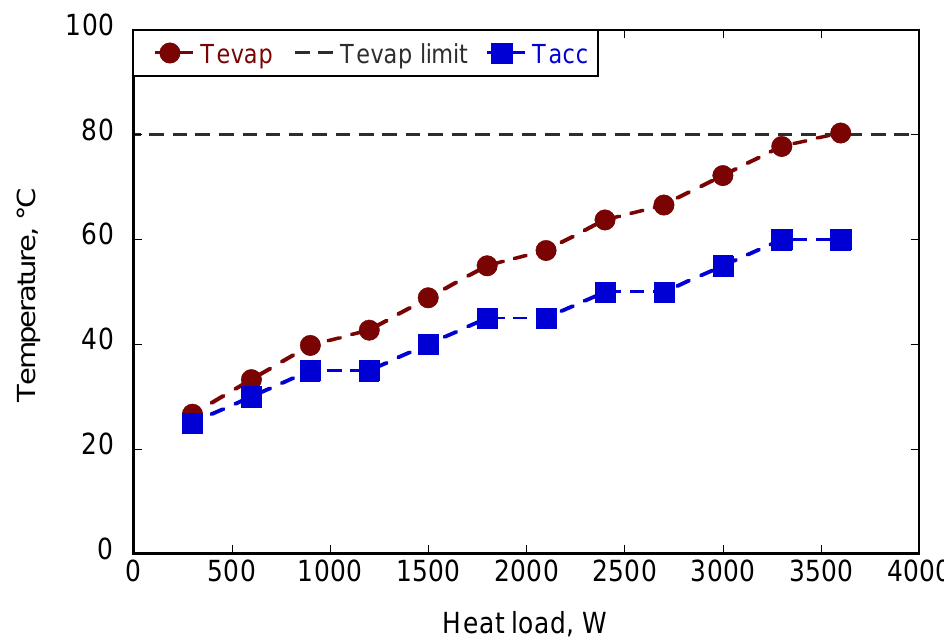
Figure 5. Calculation results of the evaporator temperature and accumulator’s lowest temperature under even heat loads conditions.